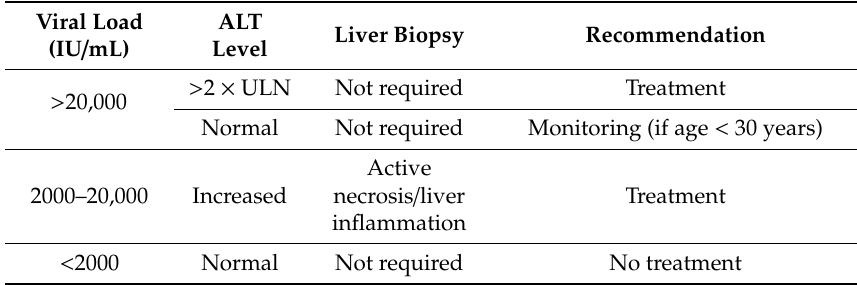
Table 4. EASL treatment indications for chronic HBV-infected